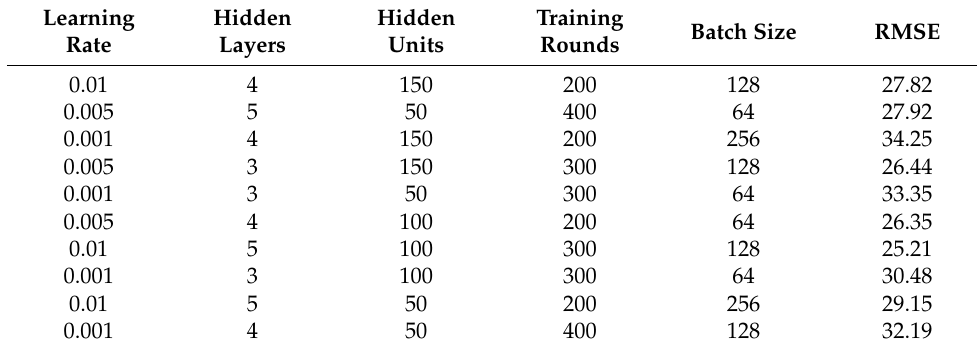
Table 3. Cross ‐ Validation grid search optimization and tuning results. Table 3. Cross-Validation grid search optimization and tuning results.